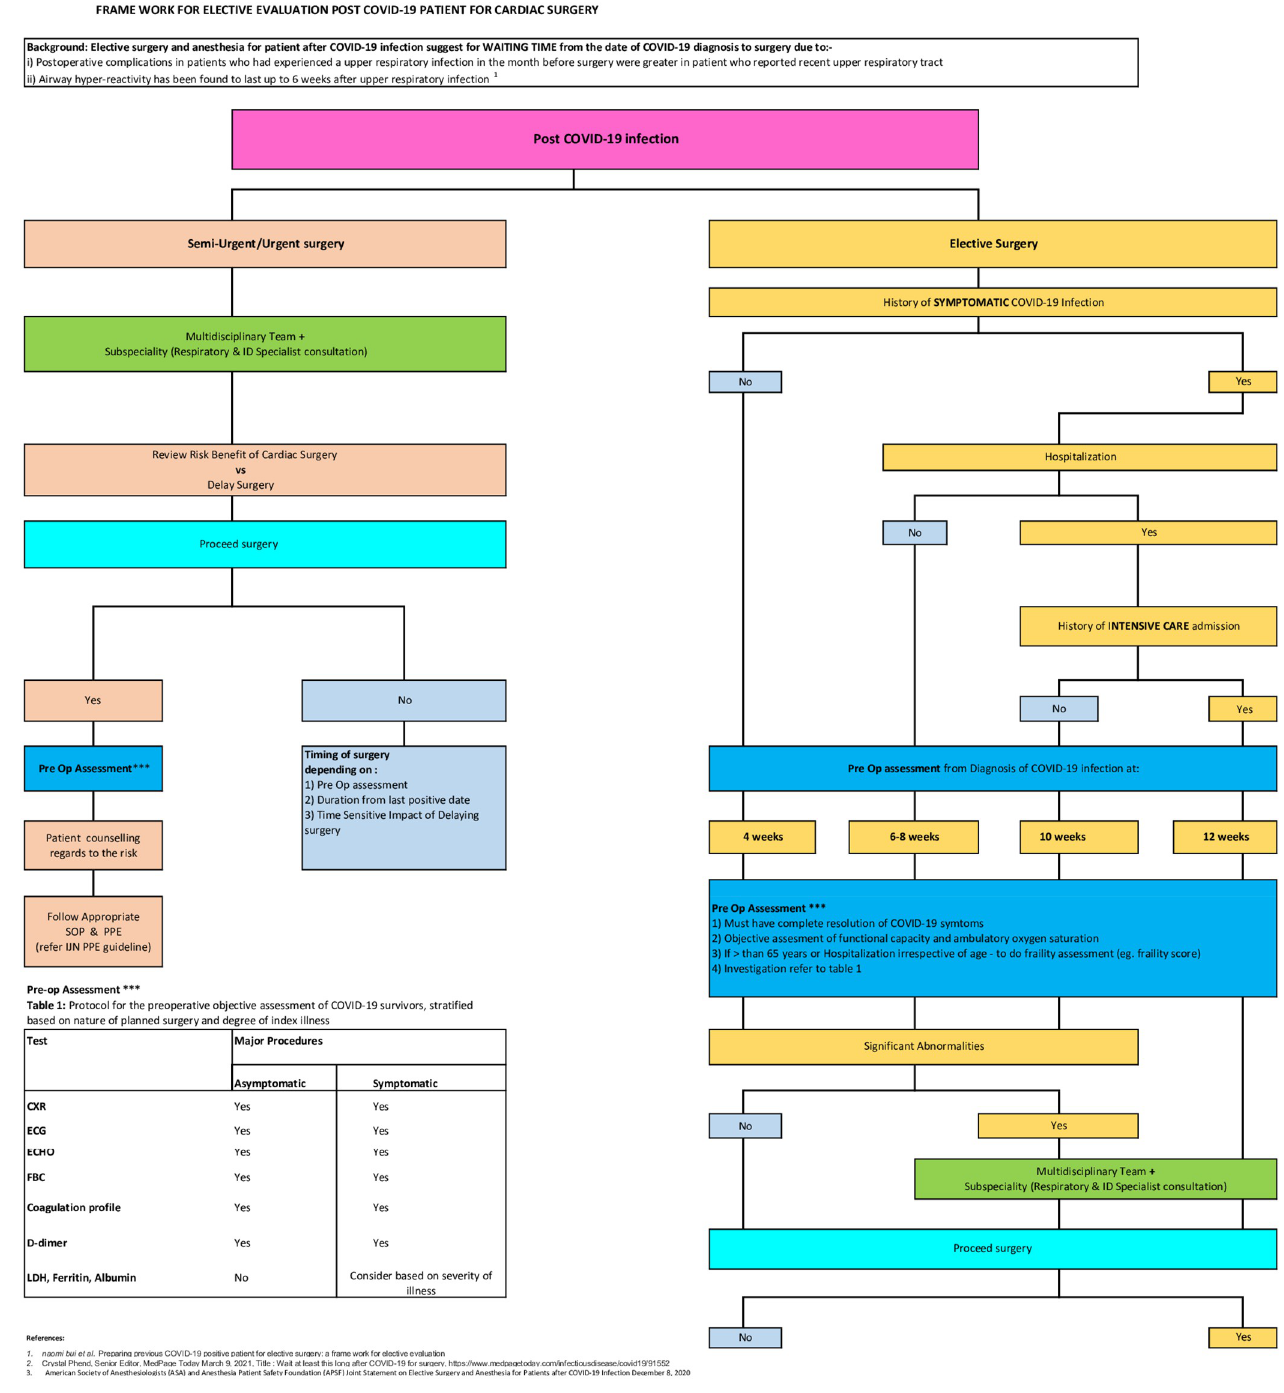
Fig 1. Framework for pre-operative evaluation for patients with pre-op COVID-19.